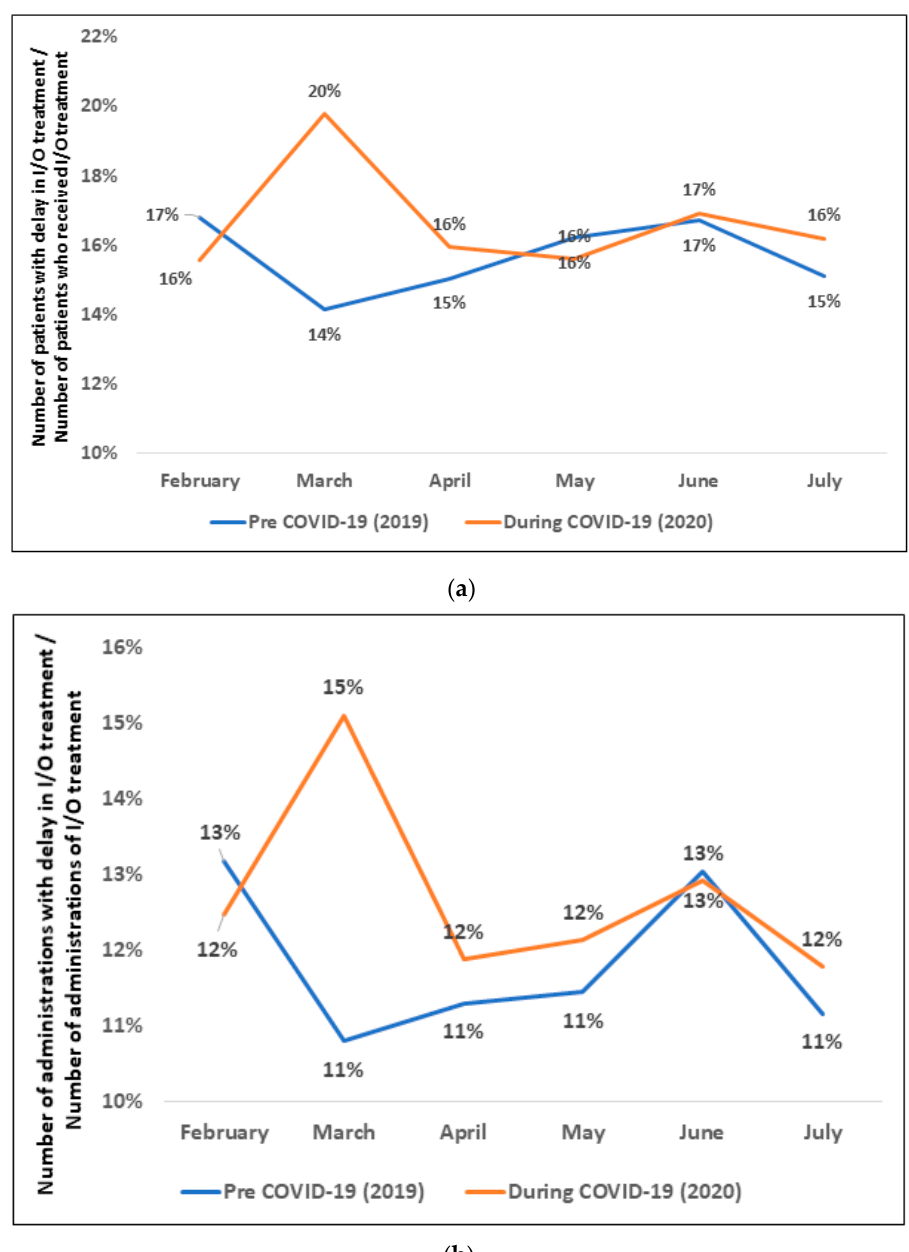
Figure 3. Delay in immunotherapy treatment in pre-COVID-19 and during-COVID-19 period ( a ) monthly percentage of patients who had a delay ( b ) monthly percentage of administrations that had a delay. I/O, immuno-oncology agent.